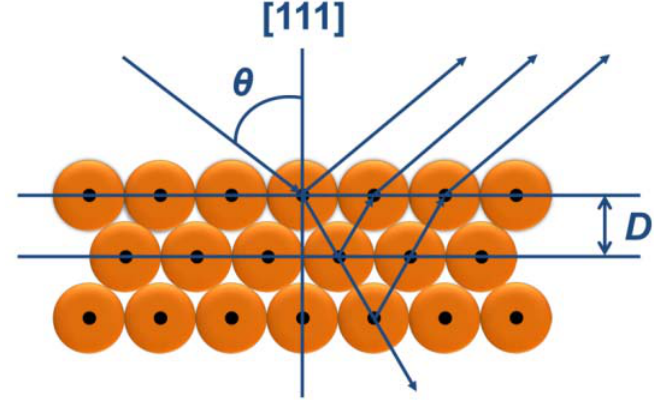
Figure 1. Incident light with a wavelength predicted by a modified Bragg-Snell equation (Equation (1)) undergoes diffraction when propagating through a PC. The wavelength of light that is coherently scattered is centered on λ , and can be estimated by the Equation (1) from the incident angle, θ , the effective refractive index of the PC, n of the structure, D